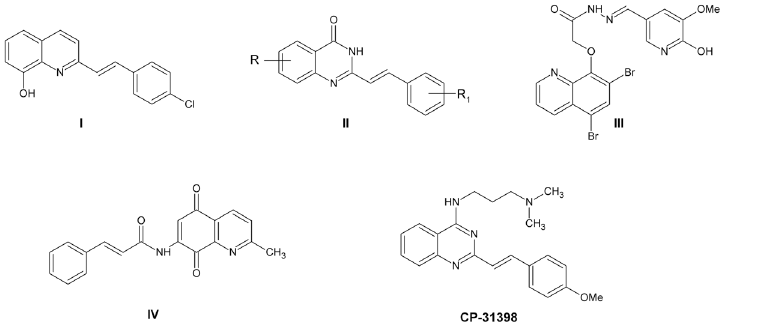
Fig 1. Quinolines and analogs with a marked anticancer